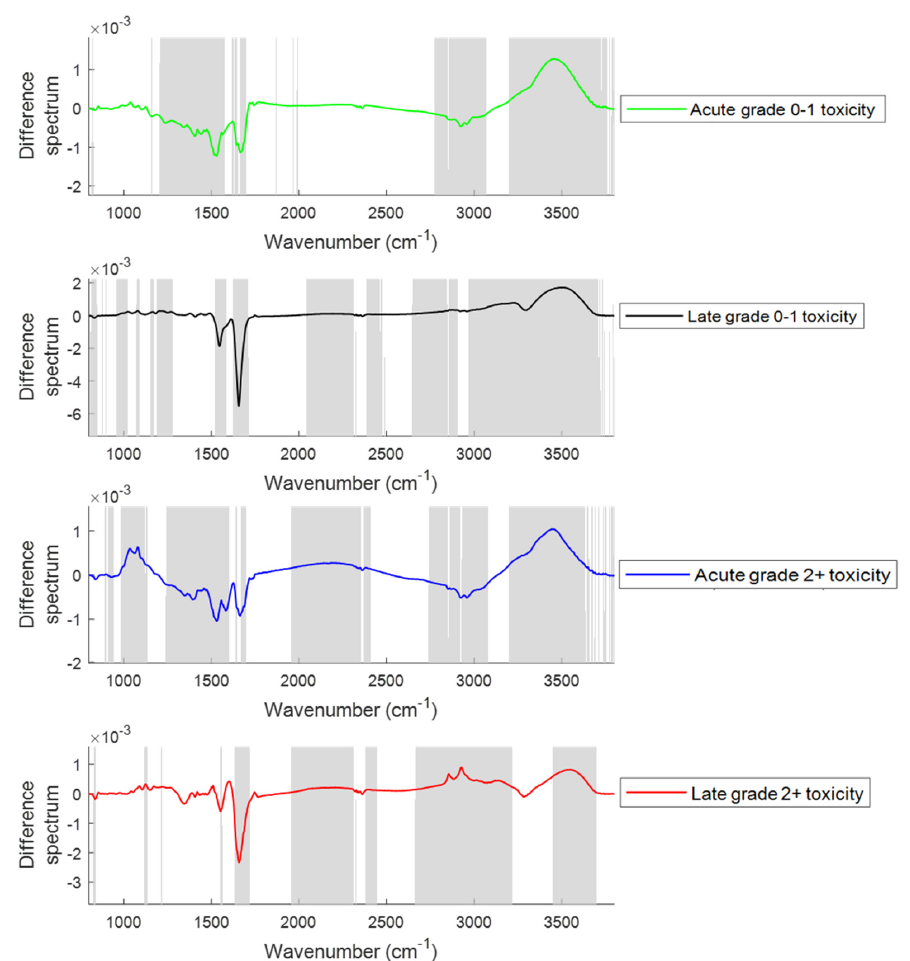
Figure 6. Difference spectra of plasma from patients at baseline and patients suffering from grade 0–1 and grade 2+ acute (immediately after completion of radiotherapy) and late (at eight months post radiotherapy) toxicity. The shaded regions depict the spectral regions which are significantly different between each sample set using a two-tailed t -test with p < 0.001.